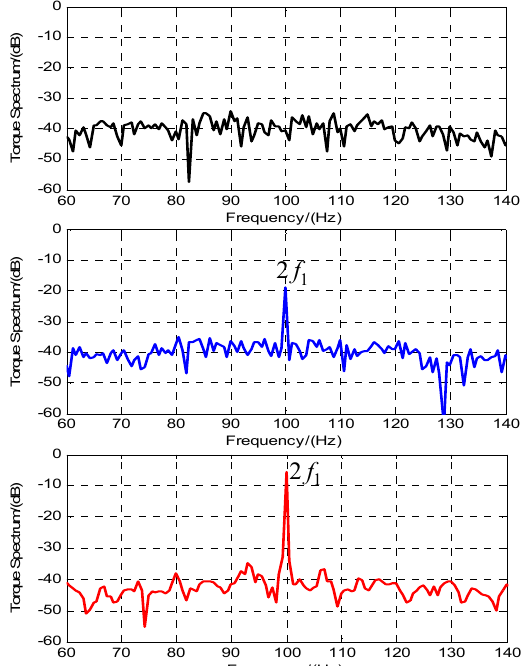
Figure 13. Torque spectrum for R f = 0.1 Ω with different shorted turns (top: health, middle: 1 turn shorted, bottom: 5 turns shorted).